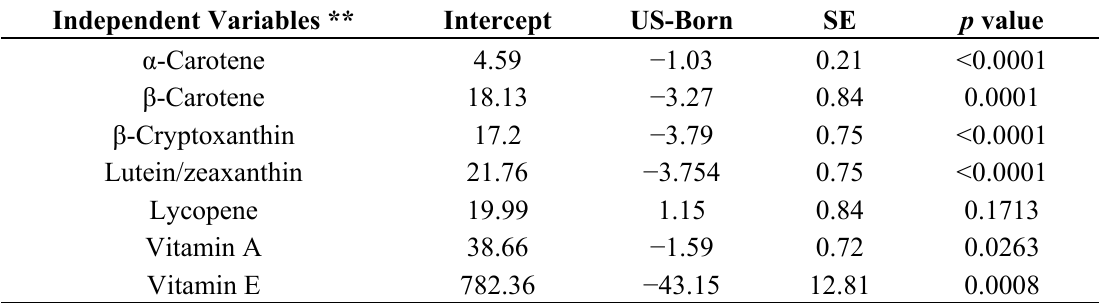
Table 3. Adjusted * Regression Coefficients for the Association of Country of Birth with Serum